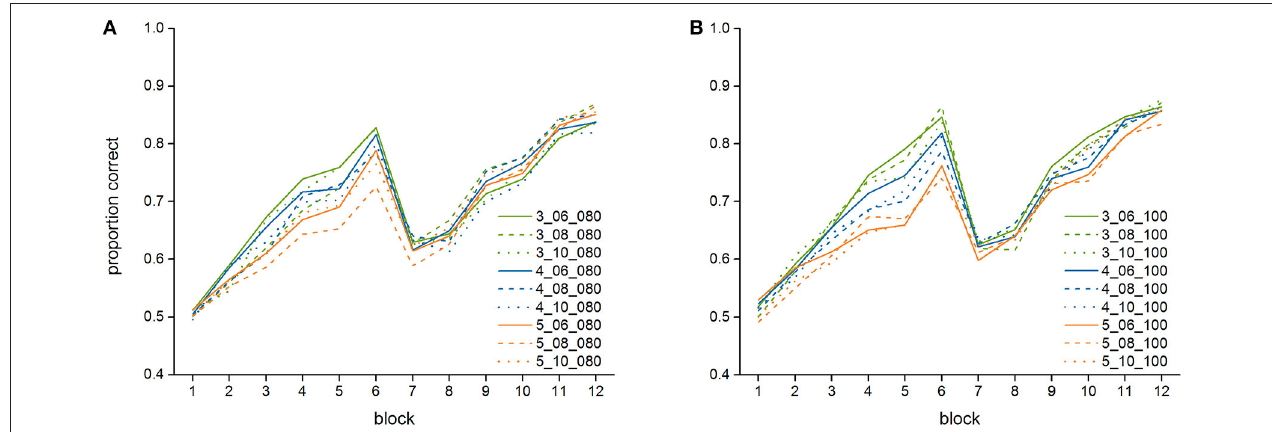
FIGURE 5 | Average performance of the 18 versions of the model in the 12 blocks of the experiment, (A) models with a declarative-finst-span of 80s, (B) models with a declarative-finst-span of 100s.